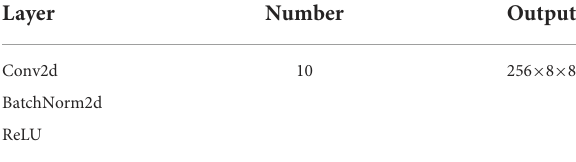
TABLE 1 Parameter of nonlinear